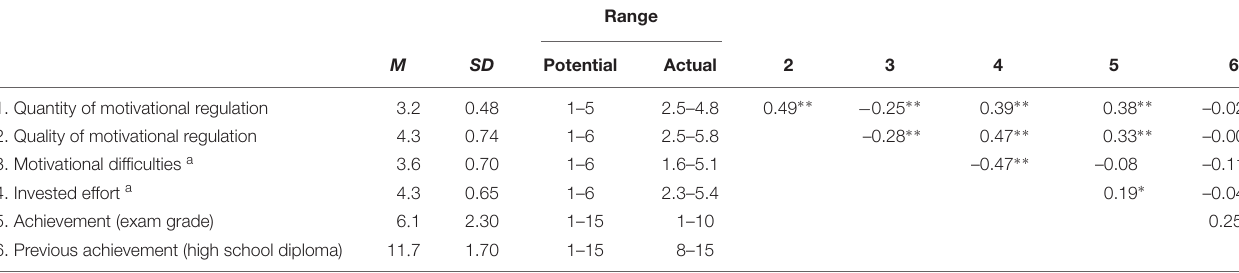
TABLE 1 | Descriptive statistics and bivariate correlations.